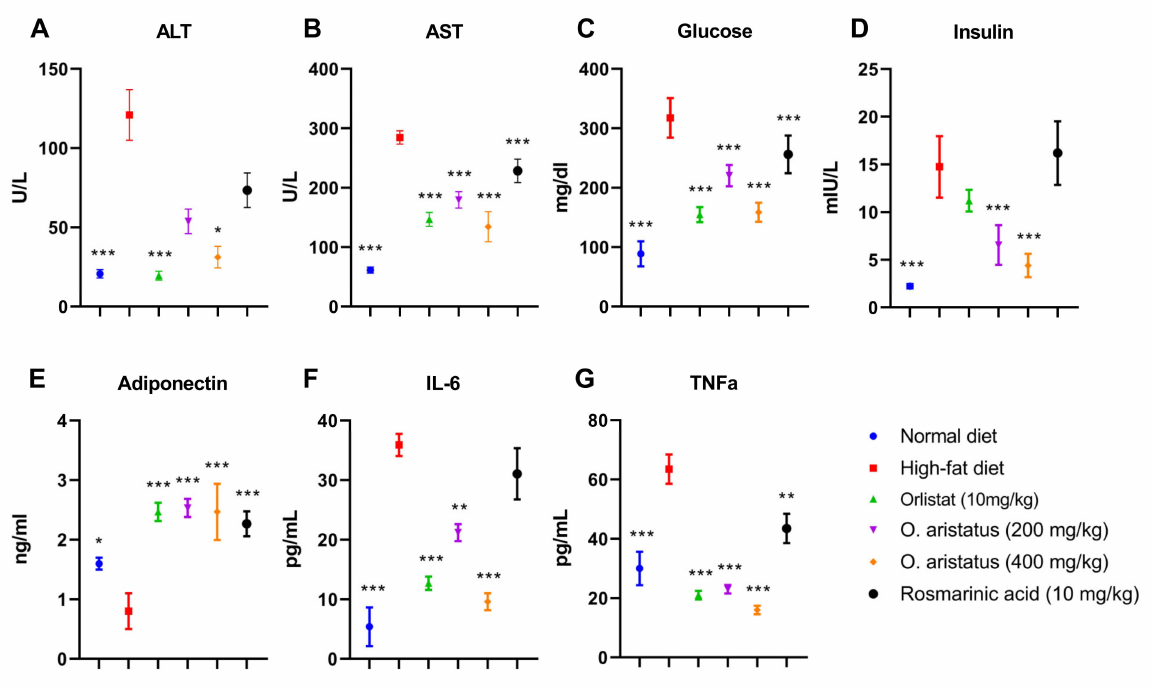
Figure 4. The effects of O. aristatus on liver enzymes, serum glucose, serum insulin, adiponectin and inflammatory cytokines. * p < 0.05, ** p < 0.01, *** p ≤ 0.001 compared to high-fat diet control group. The values were presented as mean ± SD, n = 5. Table 2. Pearson correlation between the insulin (mIU/L) and glucose (mg/dL) levels among the tested mice groups.